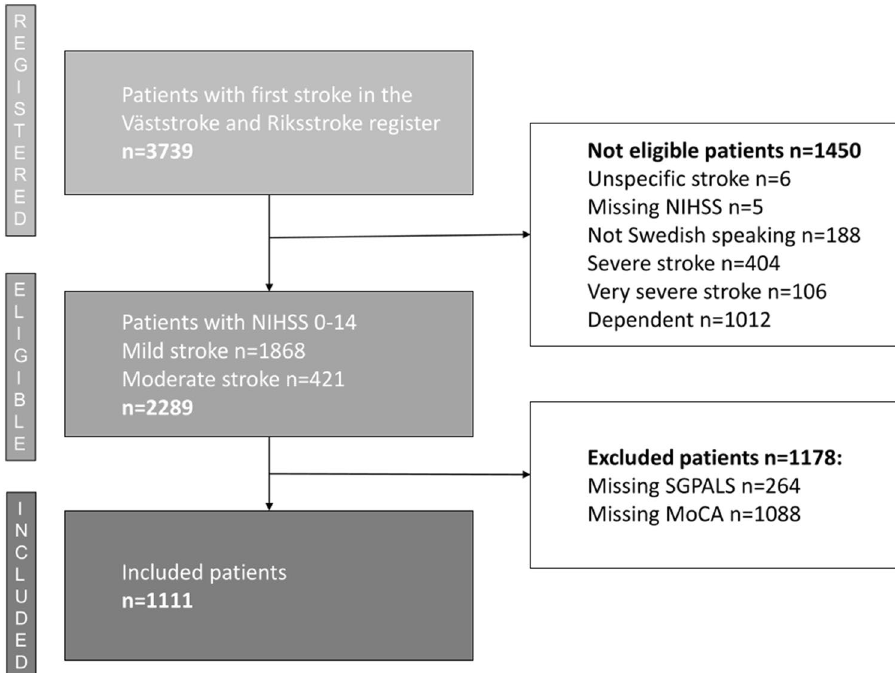
Figure 1. Flow chart of the study participants. Physical activity level was assessed using the Saltin-Grimby Physical Activity Level Scale (SGPALS), and cognition was screened using the Montreal Cognitive Assessment